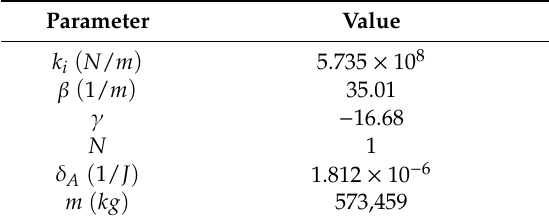
Figure 9. Reference models. ( a ) Structural model; ( b ) acceleration of the first floor. Table 4. Reference model parameters.